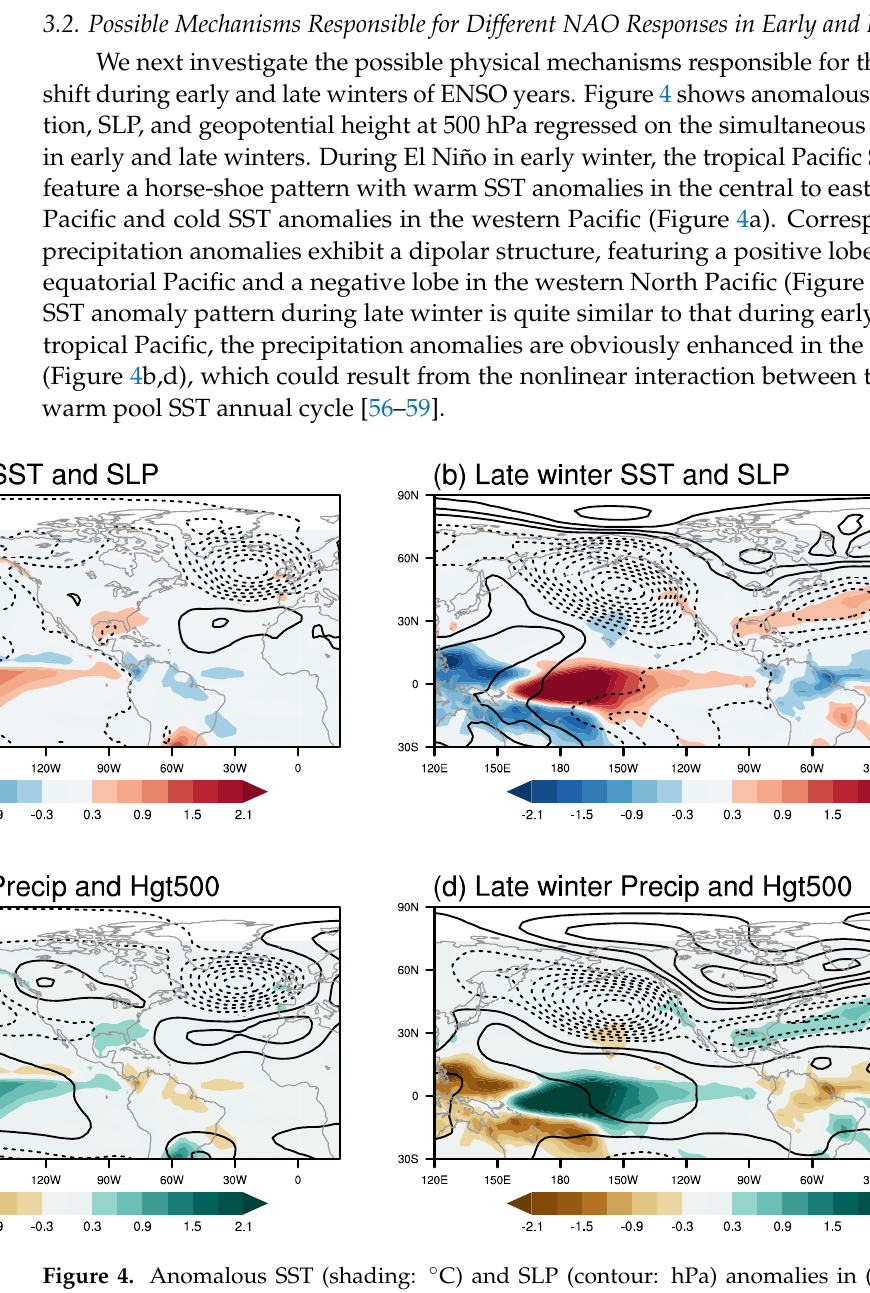
observed over the North Atlantic with a negative center near 50° N and a positive center near 30° N, zonally elongating from the central North Atlantic Ocean to Western Europe.